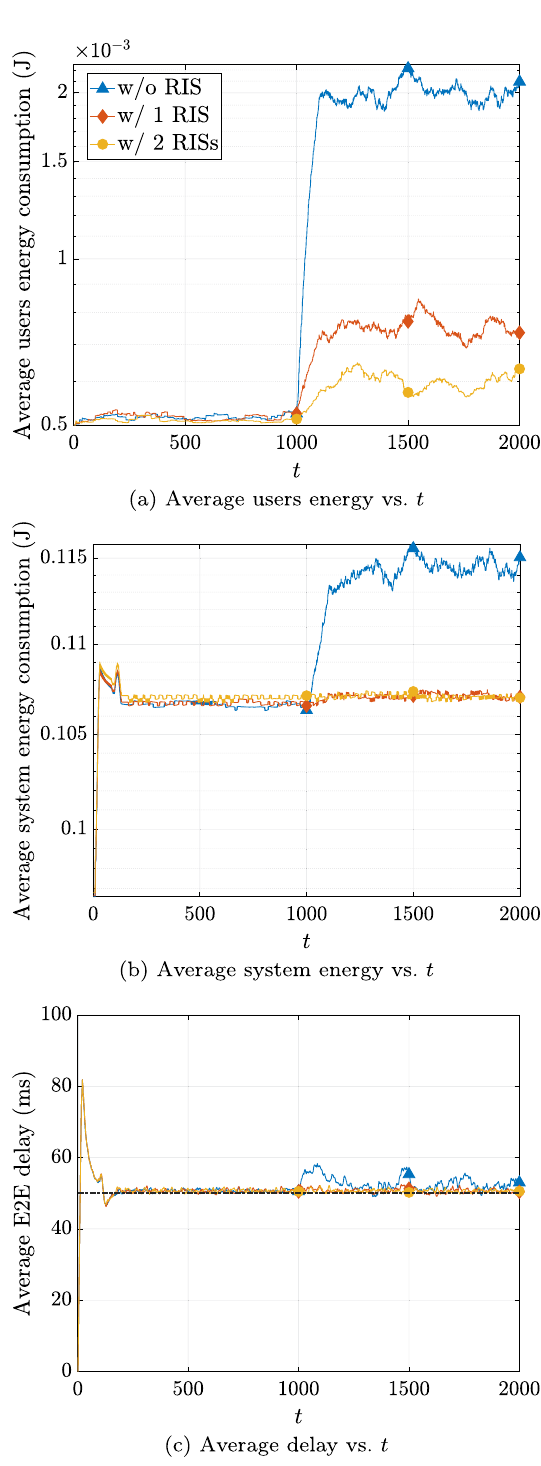
Fig. 8 Temporal behaviors of energy and delay in a non-stationary